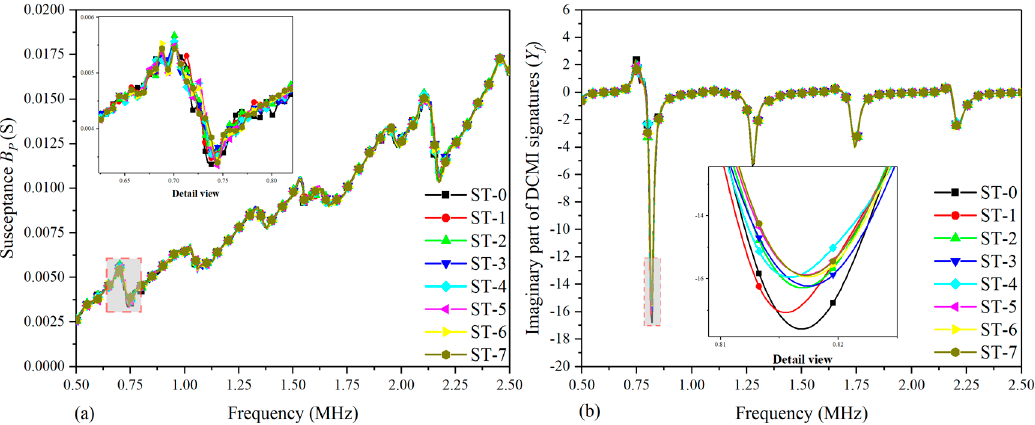
Figure 9. Comparative plots based on real part of signatures for specimen-2: ( a ) raw conductance signatures Figure 10. Comparative plots based on imaginary part of signatures for specimen-2: ( a ) raw B , ( b ) extracted DCMI signatures susceptance signatures P